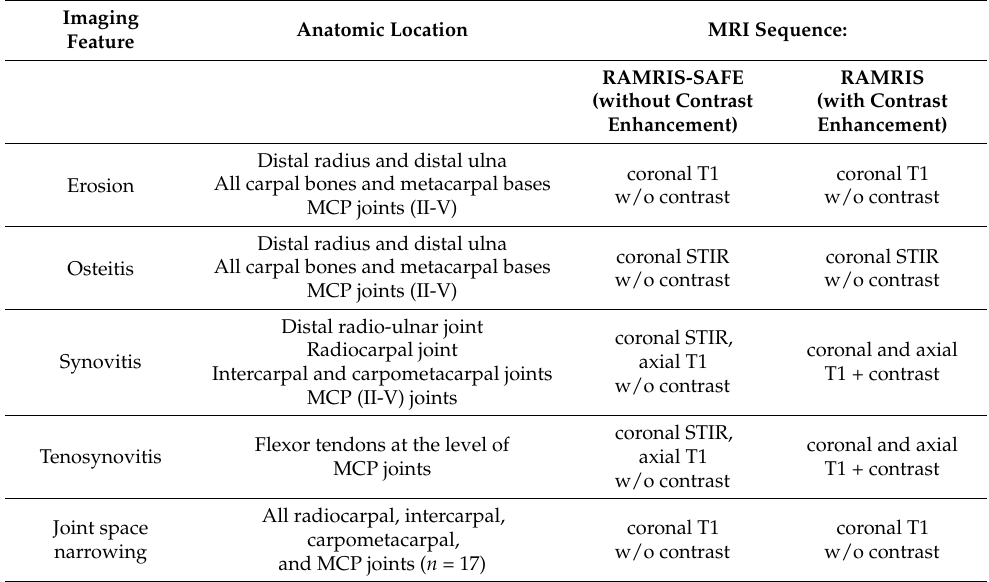
Table 1. Composition of both scores: RAMRIS-SAFE and RAMRIS.